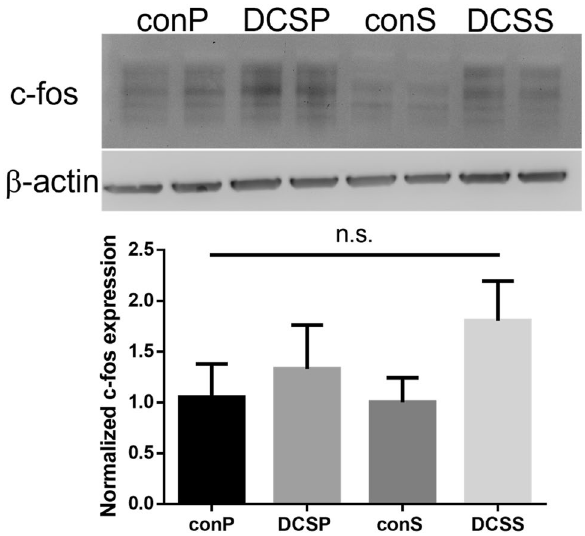
Figure 4. Normalized c-Fos protein expression in human astrocytes and representative western blot. Contrast and brightness on blot image have been altered for visibility, and the blots have been cropped. Unaltered, full- length blots presented in supplemental Fig. S3. n.s = not significant; N = 3 for each